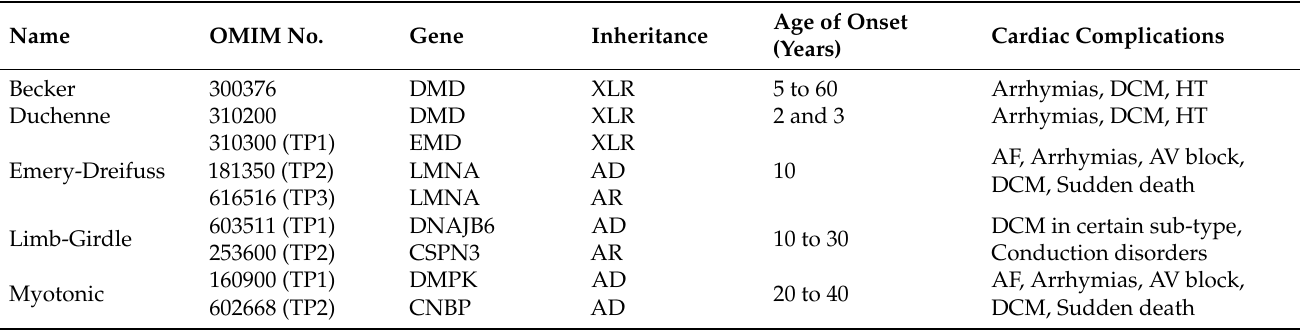
Table 1. Examples of different types of muscular diseases associated with cardiac abnormalities. OMIM accessed on 1 May